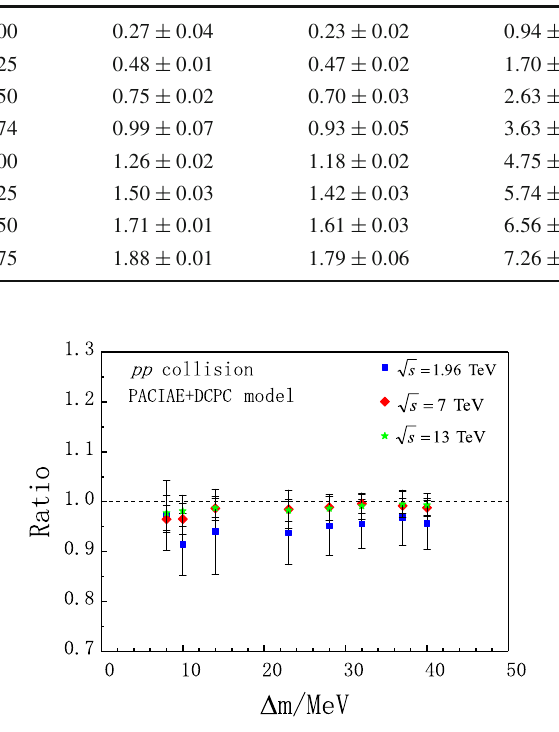
Fig. 2 The ratio distribution of Z − c ( 3900 ) to Z + c ( 3900 ) in pp colli- √ s = 1 . 96 , 7 and 13 TeV with the value of radius parameter sions at R 0 = 1 . 74 fm, as a function of mass uncertainty (cid:5)